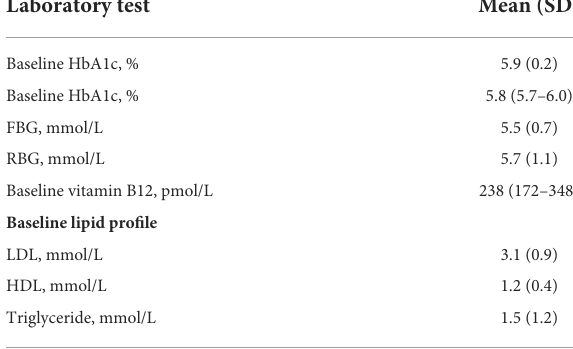
TABLE 2 Patients’ baseline laboratory